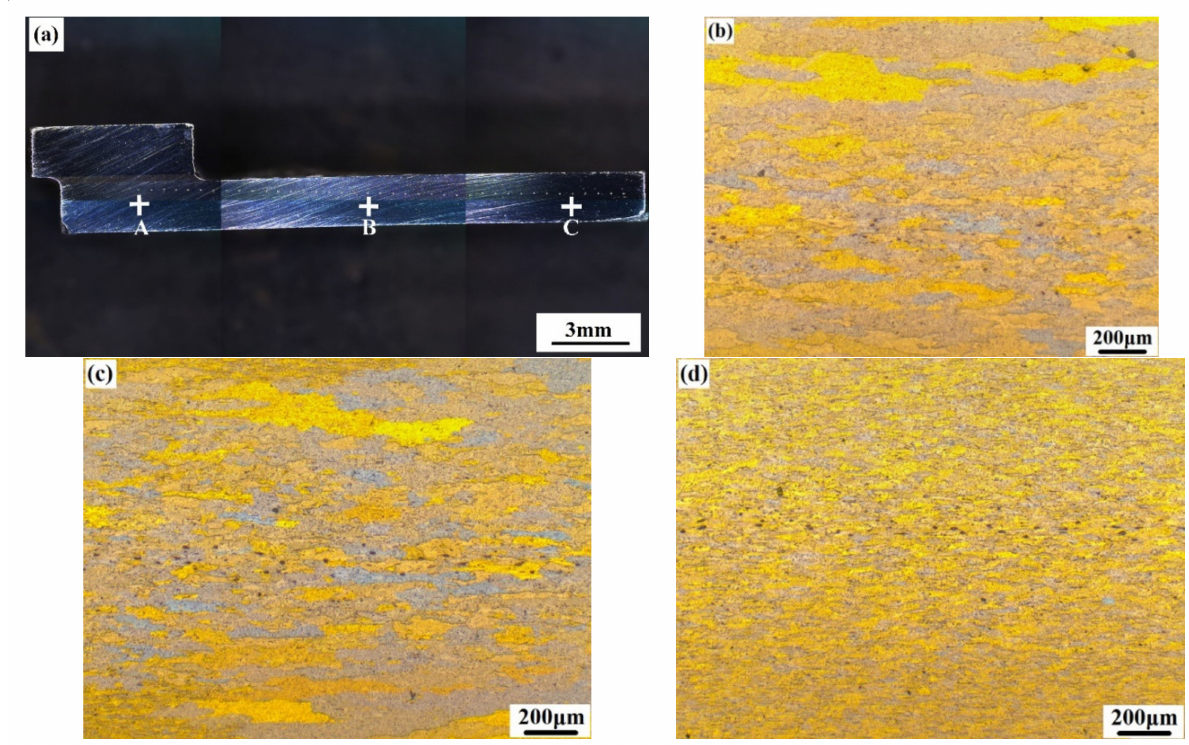
Figure 13. ( a ) The brazed joint cross section after microhardness test; ( b ) The grain morphology at point A; ( c ) The grain morphology at point B; ( d ) The grain morphology at point C.